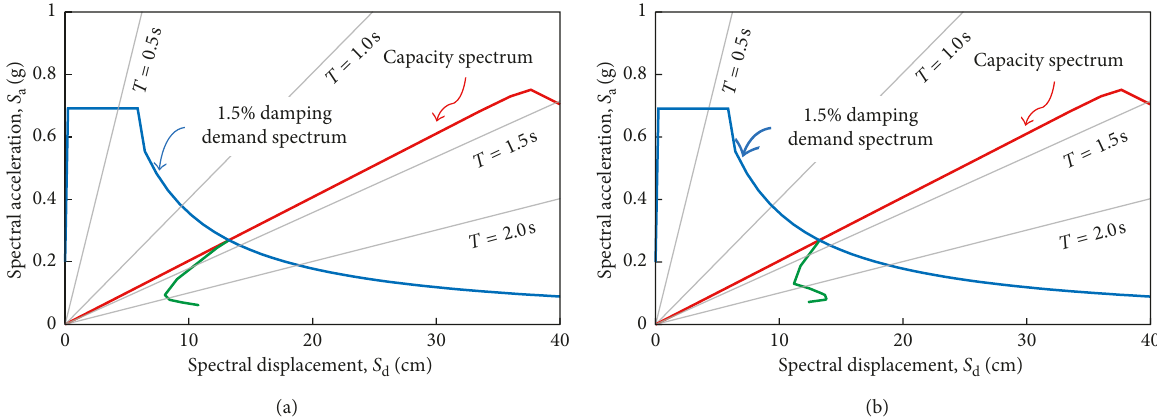
Figure 9: Pushover analyses: (a) CSM of ATC-40 and (b) ELM of FEMA